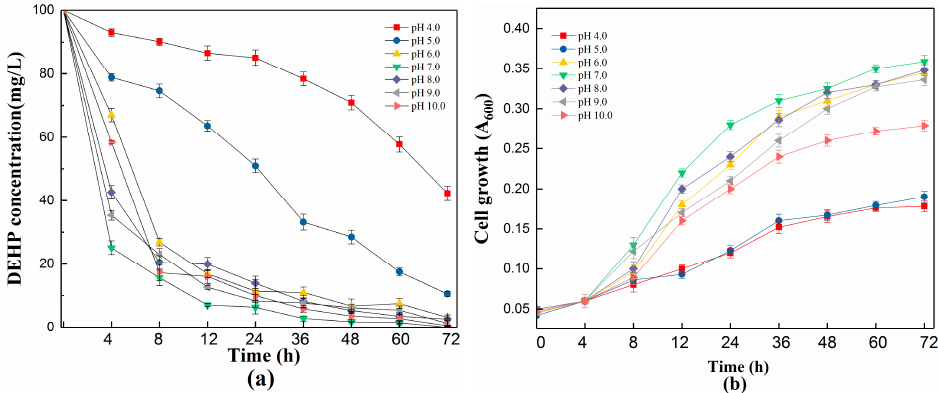
Figure 3. Effects of initial pH on DEHP degradation and cell growth of strain YC-YT1. ( a ) Effects of initial pH on DEHP degradation; ( b ) Effects of initial pH on the cell growth of strain YC-YT1. Error bars indicate standard deviations of the means.